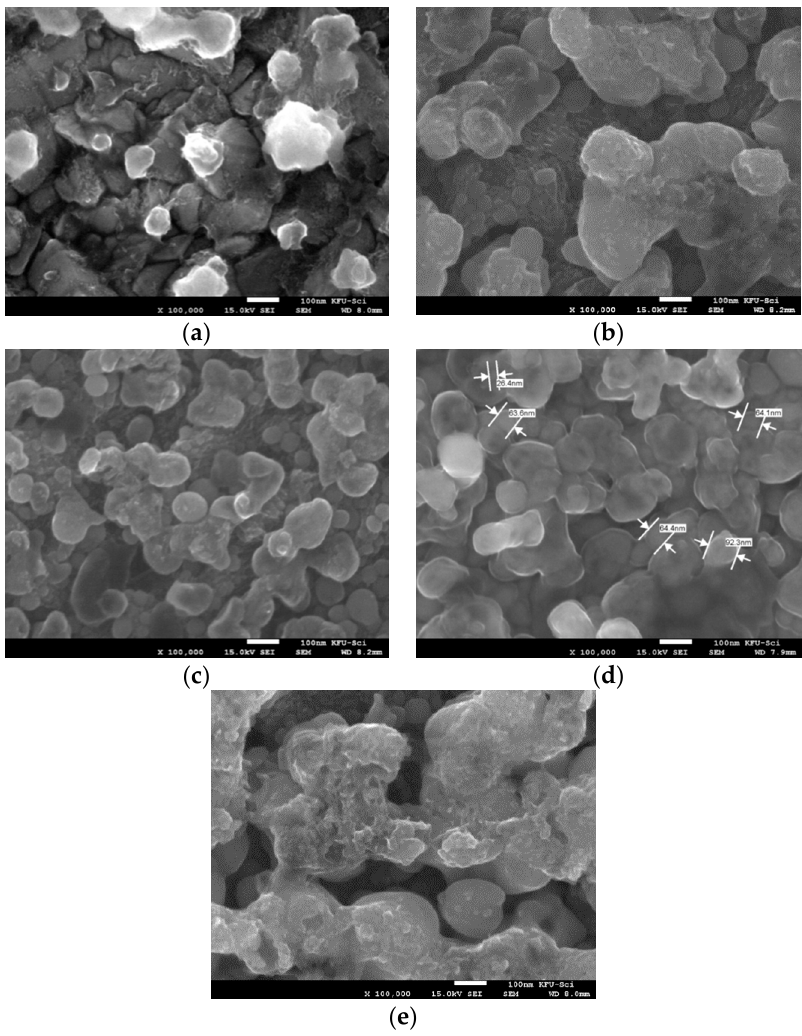
Figure 6. SEM micrographs of ( a ) Pristine film (Y0%) ( b ) Y1% (c) Y2% ( d ) Y3% ( e ) Y4% films. The SEM micrographs in Figure 6 depict films with average diameters (sizes) as follows: Y0%: 50.02, Y1%: 43.66, Y2%: 42.16, Y3%: 45.10, and Y4%: 47.93. These mean particle sizes are in fairly good